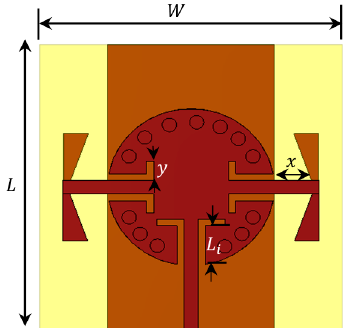
Figure 4. Configuration of the proposed antenna array.